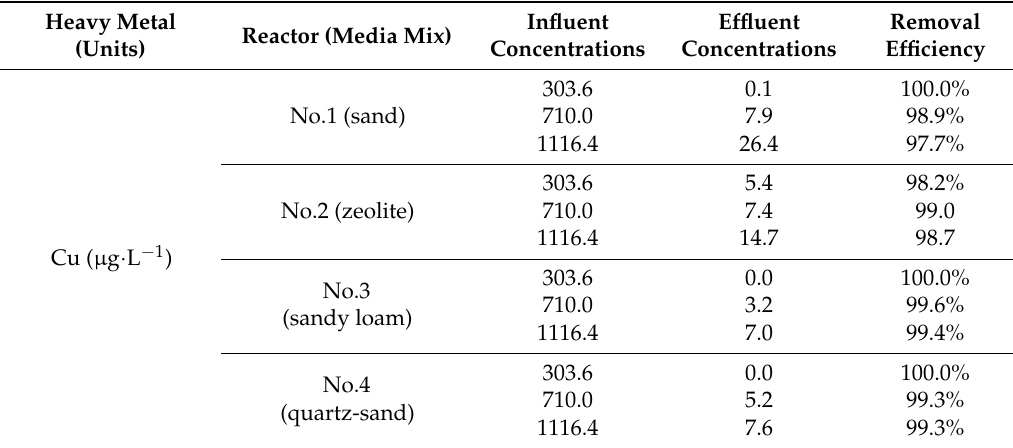
Table A1. Measured influent and effluent concentrations of heavy metals and calculated removal efficiencies